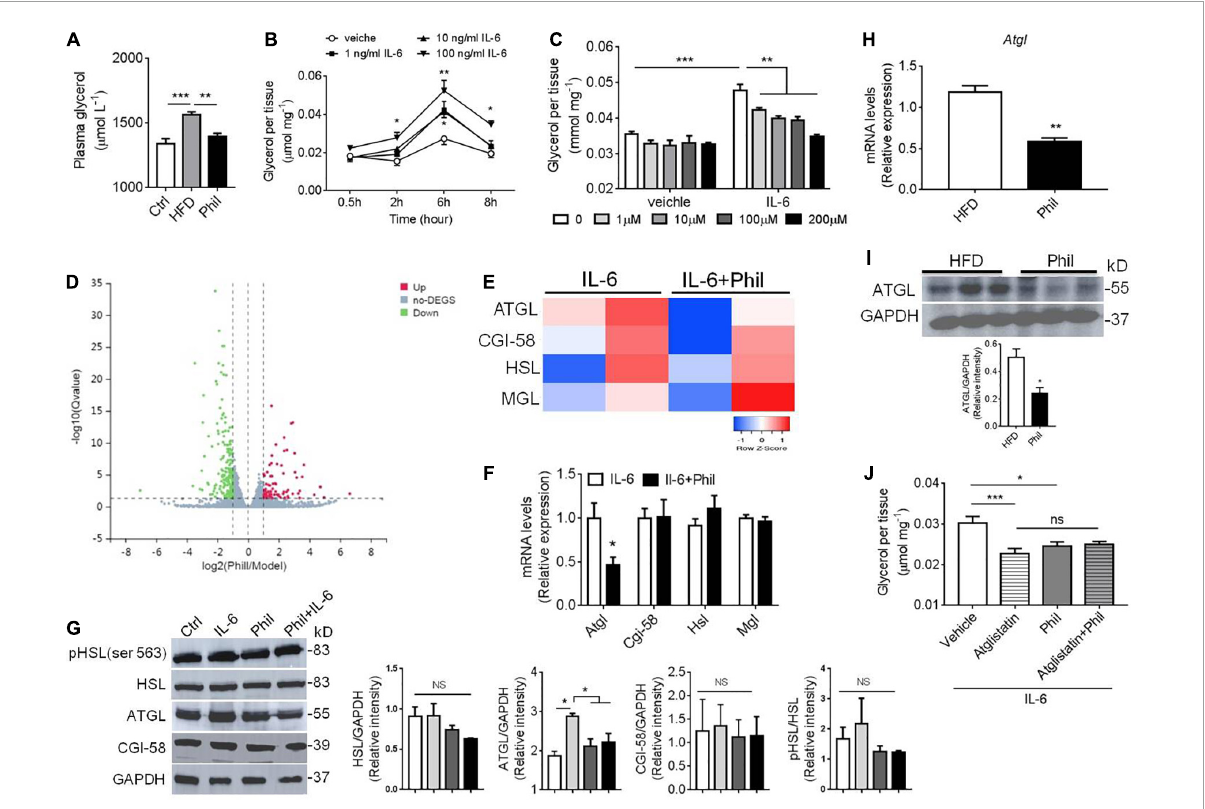
FIGURE4 Phillyrin decreases IL-6-related basal lipolysis associated with ATGL inhibition. (A) Plasma level of glycerol in mice fed a normal diet or HFD in the presence or absence of Phillyrin (25 mg per kg body weight). N = 4–5 per group. (B) Time-dependent alterations of basal lipolysis in the gWAT explants of WT mice in the presence of 0, 1, 10, 100 ng/ml IL-6. N = 3 per group. (C) Effects of Phillyrin ranged from 0, 1, 10, 100, 200 µ M on basal lipolysis in the presence of 100 ng/ml IL-6 or not were assessed in vitro in the gWAT pieces of WT mice cultured for 6 h. N = 4 per group. (D) A volcano plot of gene expression elaborating the up-regulated and down-regulated genes with a total number of 680 represented by claret and green dots, respectively (E) a heatmap of genes involved in lipolysis in the gWAT explants treated with or without 200 µ M Phillyrin in the presence of 100 ng/ml IL-6 for 24 h. N = 2 per group. (F) mRNA levels of ATGL, CGI-58, HSL, and MGL in the gWAT explants in the gWAT explants treated with or without 200 µ M Phillyrin in the presence of 100 ng/ml IL-6 for 24 h. N = 6 per group. (G) Representative images of immunoblots of lysates of lipolytic proteins from control (Ctrl), 100 ng/ml IL-6 stimulated gWAT explants or Phillyrin-treated gWAT explants in the presence of IL-6 for 24 h. N = 3 per group. (H) mRNA level of ATGL in HFD-fed mice treated with or without Phillyrin (25 mg per kg body weight). N = 4 per group. (I) Protein level of ATGL in HFD-fed mice treated with or without Phillyrin (25 mg per kg body weight). N = 3 per group. (J) Basal lipolysis in the gWAT pieces of WAT mice treated with vehicle, atglistatin (25 µ M), Phillyrin 200 µ M or atglistain + Phillyrin in the presence of 100 ng/ml IL-6 for 6 h. N = 6 per group. All data in the figure were presented as mean ± SEM. * P < 0.05, ** P < 0.01, and *** P <